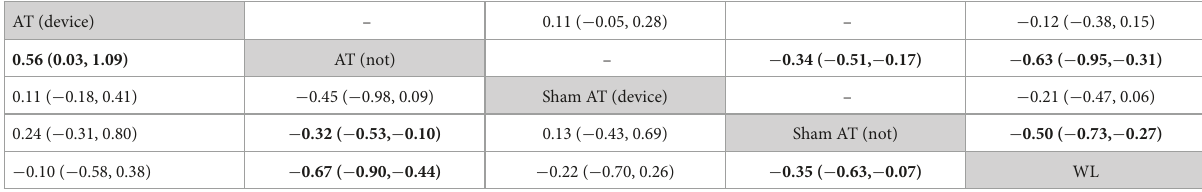
TABLE 2 League table for pairwise meta-analysis (upper right) and network meta-analysis (lower left): pain intensity. AT (device)